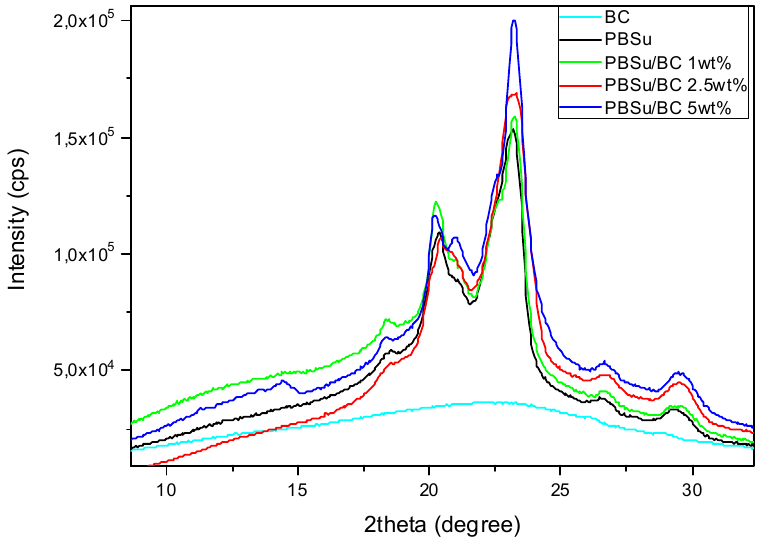
Figure 3. XRD patterns of neat PBSu, BC, and PBSu/BC biocomposites containing 1, 2.5, and 5 wt% of BC filler.